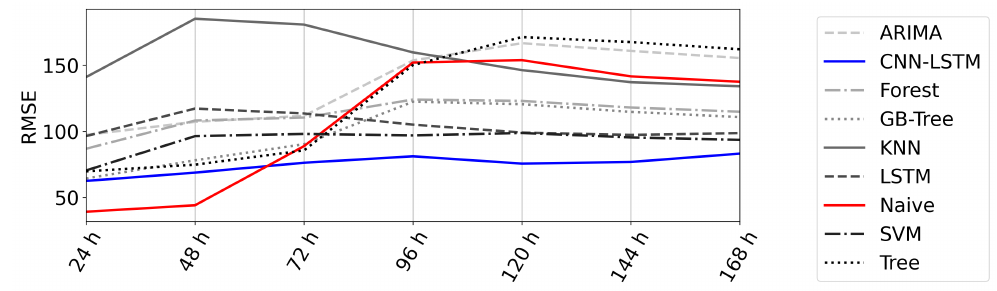
Figure 8. Model comparison over time for test scenario 2.